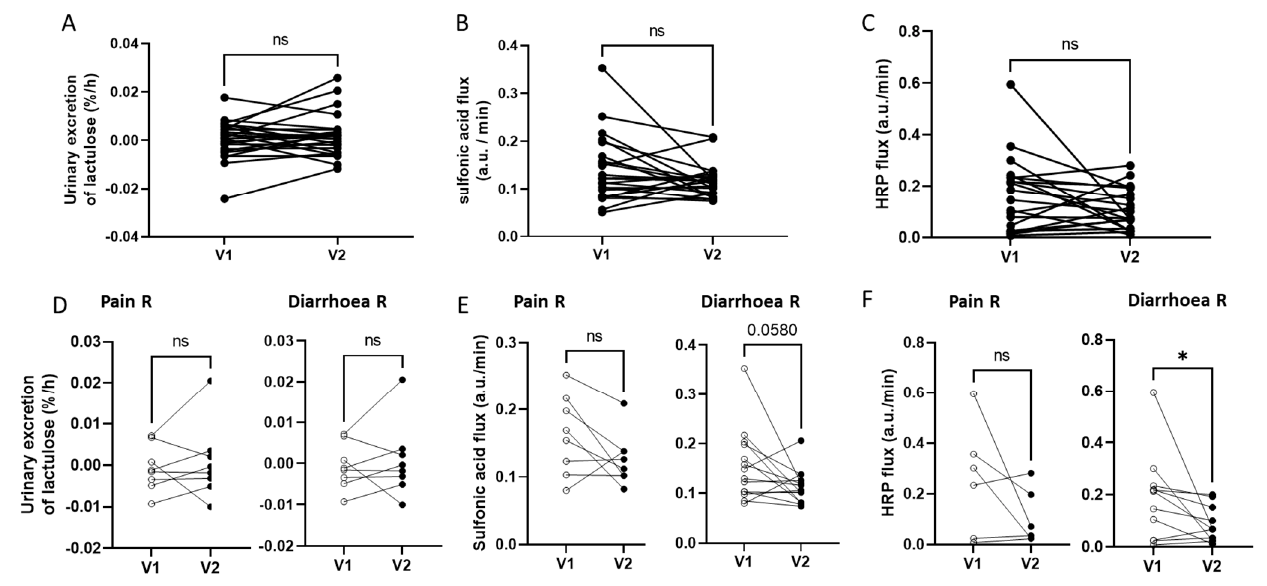
Figure 3. Impact of a 4-week supplementation with the multistrain probiotic on intestinal permeability in the per-protocol population as a whole ( A – C ) and in responders in terms of Pain (Pain R) and Diarrhoea (Diarrhoea R) ( D – F ). ( A , D ) In vivo permeability, measured by the lactulose/mannitol test; the slope of urinary excretion of lactulose from 2 to 4 h after ingestion between V1 and V2; ( B , E ) ex vivo paracellular permeability, assessed by the acid flux in colonic biopsies at V1 and V2; ( C , F ) ex vivo transcellular permeability, measured by the horseradish peroxidase (HRP) flux in colonic biopsies at V1 and V2; ns: not significant. Wilcoxon test, *: p < 0.05.